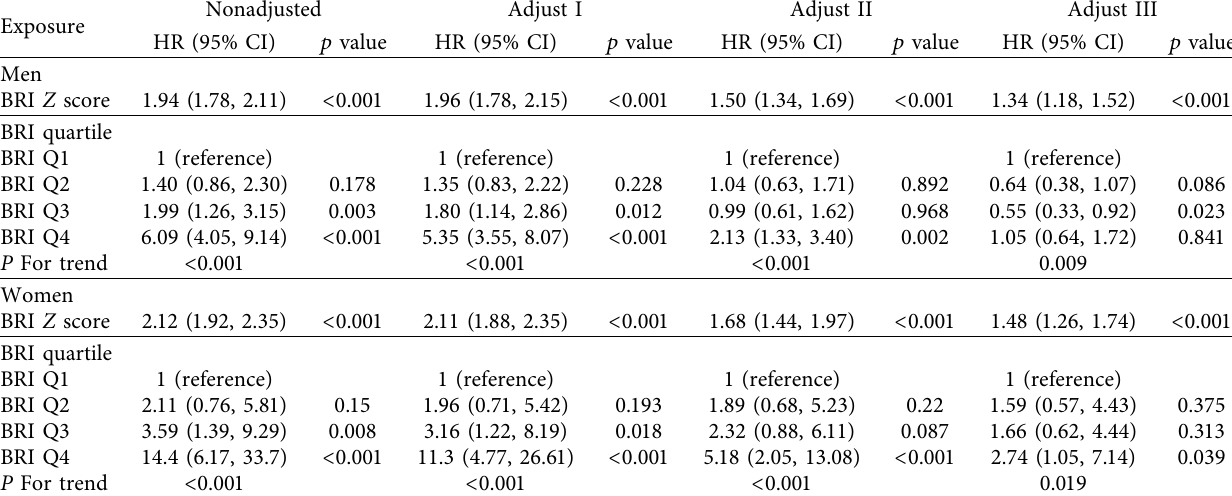
Table 2: Association between BRI and incident T2DM by gender in the NAGALA study.